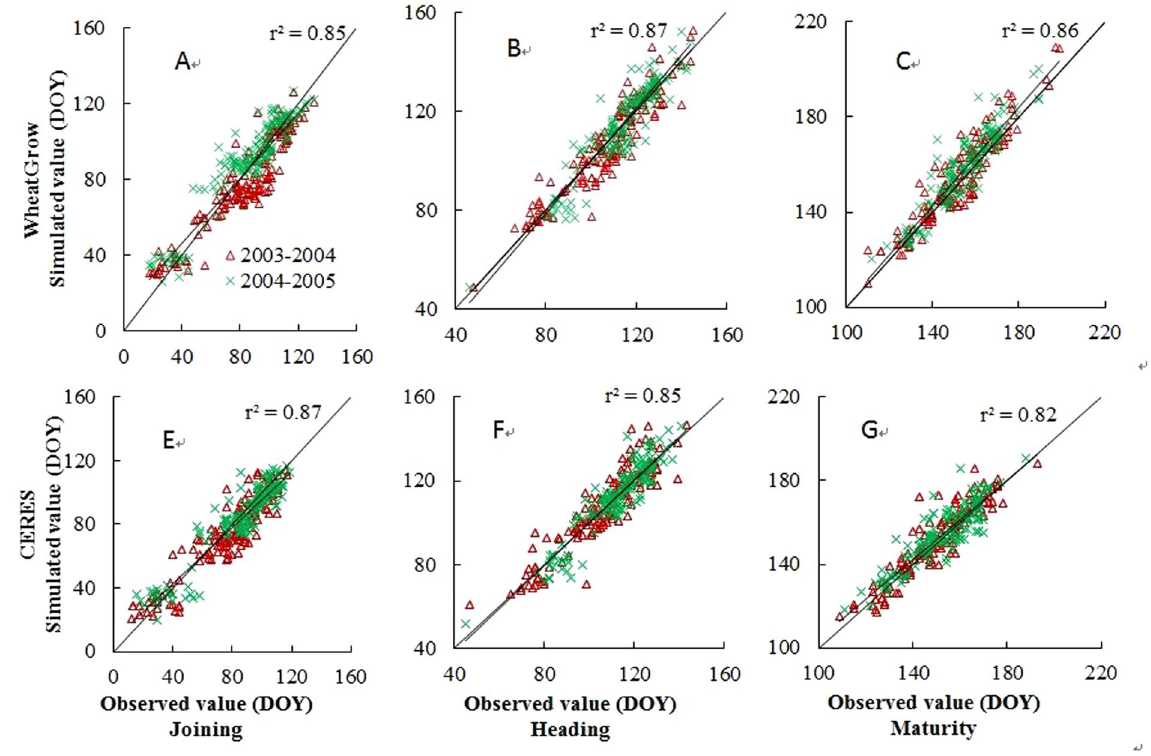
Figure 3. Comparison between simulated and observed values of jointing, heading and maturity dates in wheat at regional scale with the WheatGrow ( A , B and C ) and the CERES-Wheat ( E , F and G ) models.